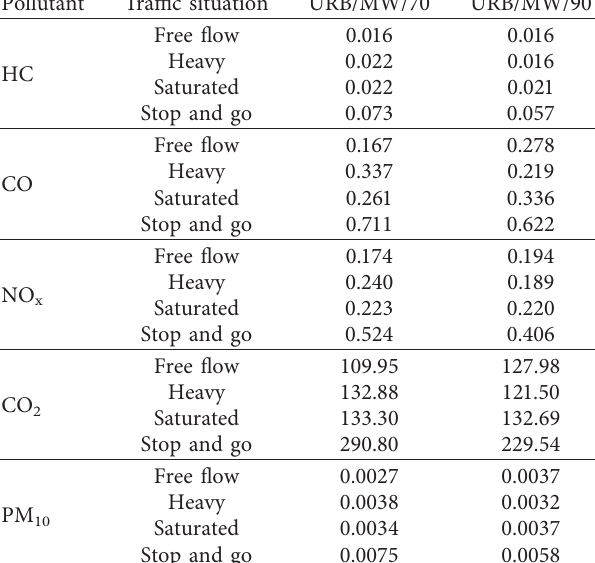
Table 3: The HBEFA emission factors used for this study in grams of pollutant emitted per kilometre for five pollutants (HC, CO, NO x , CO 2 , and PM 10 ), four traffic situations (Free flow, Heavy, Saturated, and Stop and go), and for two road types, urban mo- torway with a speed limit of 70km/h (URB/MW/70) and urban motorway with a speed limit of 90 km/h